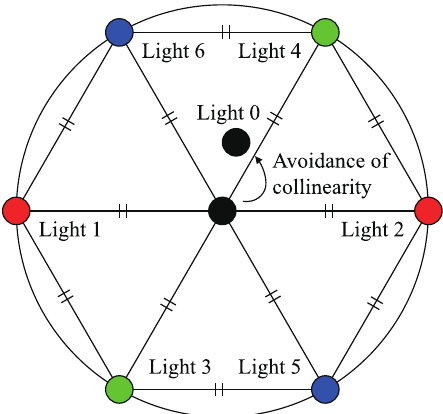
Figure 12. Schematic illustration of the geometrical location of seven light sources. Six lights are placed at each apex of a regular hexagon. Multispectral camera is placed at the center of the hexagon. Infrared light is placed near the